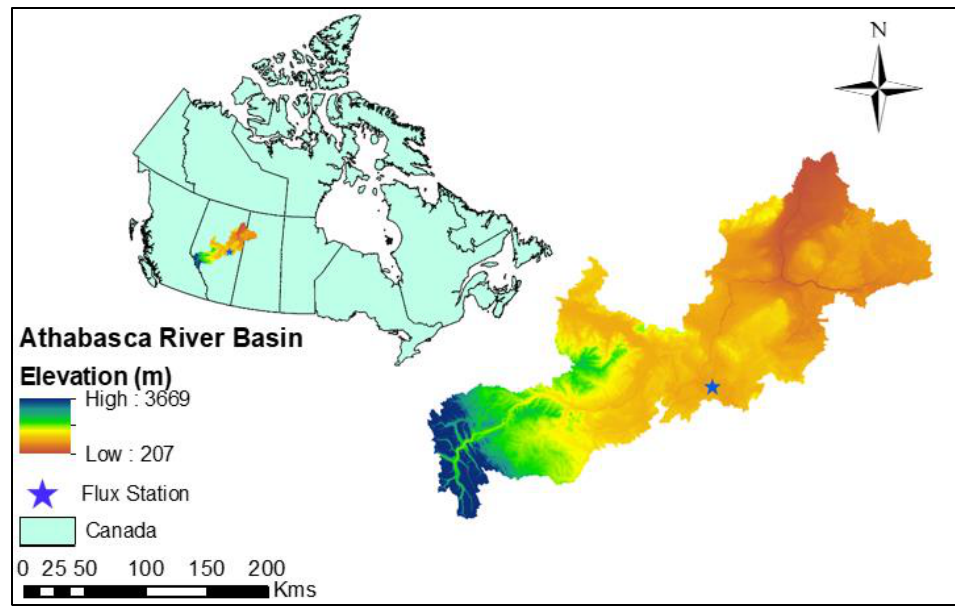
Figure 1. DEM map of Athabasca River Basin and location of flux station.